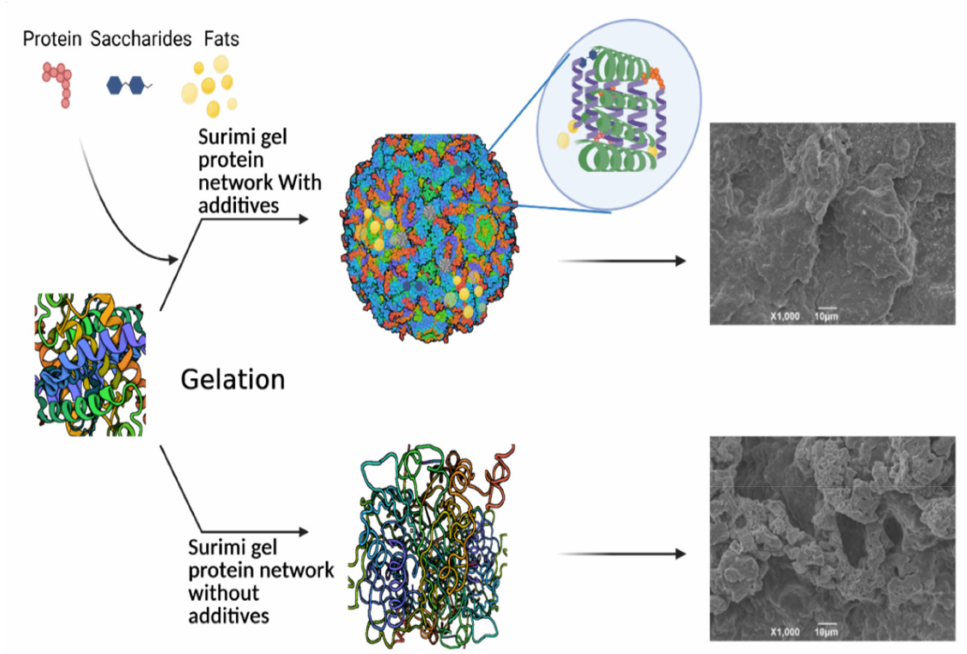
Figure 1. Surimi gelling properties with and without incorporation of additives. Microstructure figures reprinted from Walayat, Xiong, Xiong, Moreno, Li, Nawaz, Zhang, Wang and Niaz